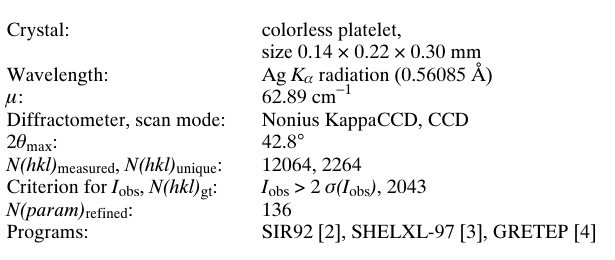
Table 1. Data collection and